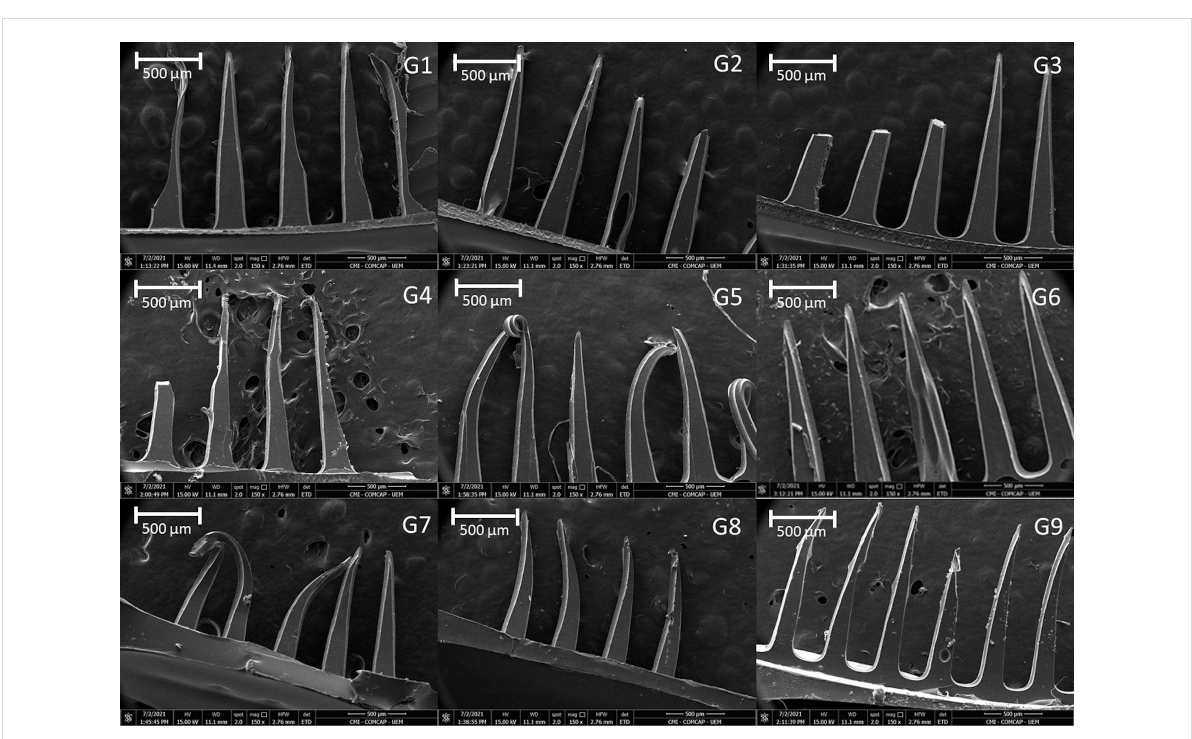
Figure 4: Micrograph obtained by scanning electron microscopy (SEM) showing the surface morphology of microneedles containing glycolic extract of propolis (G1 to G9); magnification